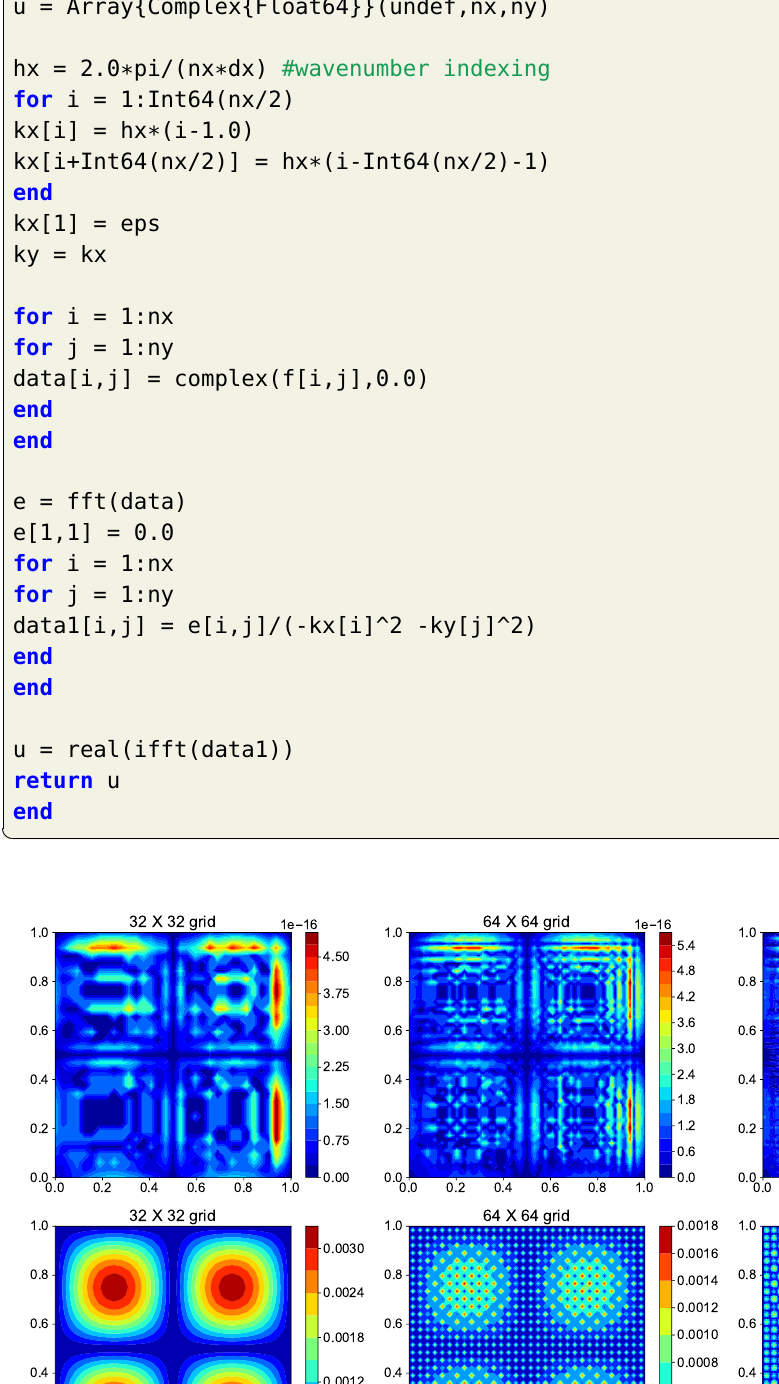
u exact u numerical | − |